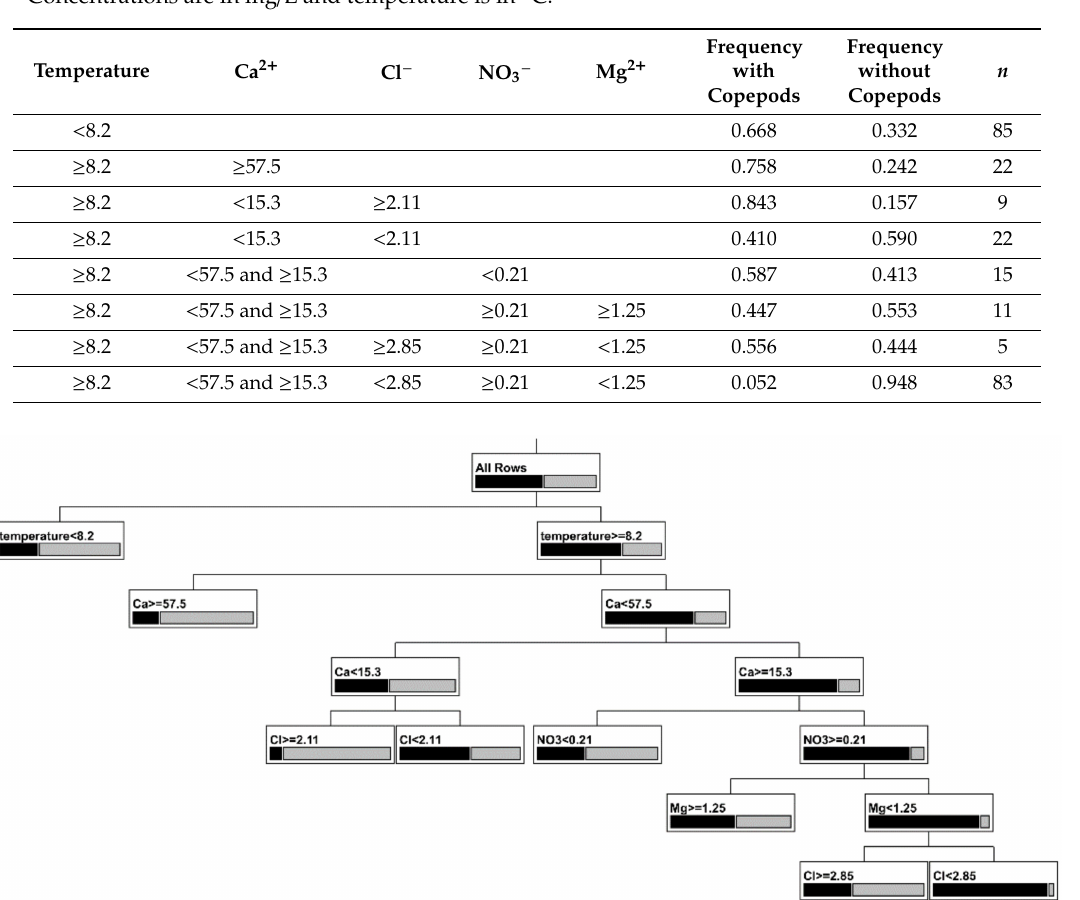
Figure 5. Classification tree for presence or absence of epikarst copepods. The size of the black rectangle is the relative number of empty samples and the size of the gray rectangle is the relative number of samples with copepods. See Table 6 for